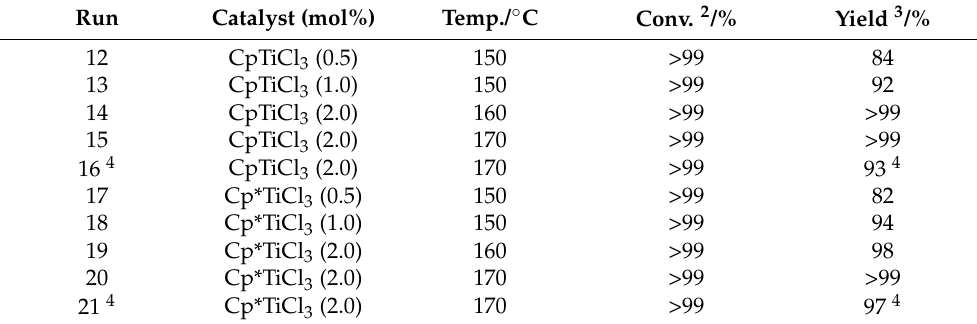
Figure 4. 13 C ( up ) and 1 H ( bottom ) NMR spectra (in CDCl 3 at 25 °C) for the reaction mixture of transesterification of PET with ethanol by CpTiCl 3 (2.0 mol%). Conditions: PET 500 mg, ethanol 5.0 mL, 170 °C, 24 h (run 15). Table 2. Depolymerization of PET with ethanol by Cp’TiCl 3 (Cp’ = Cp, Cp*) 1